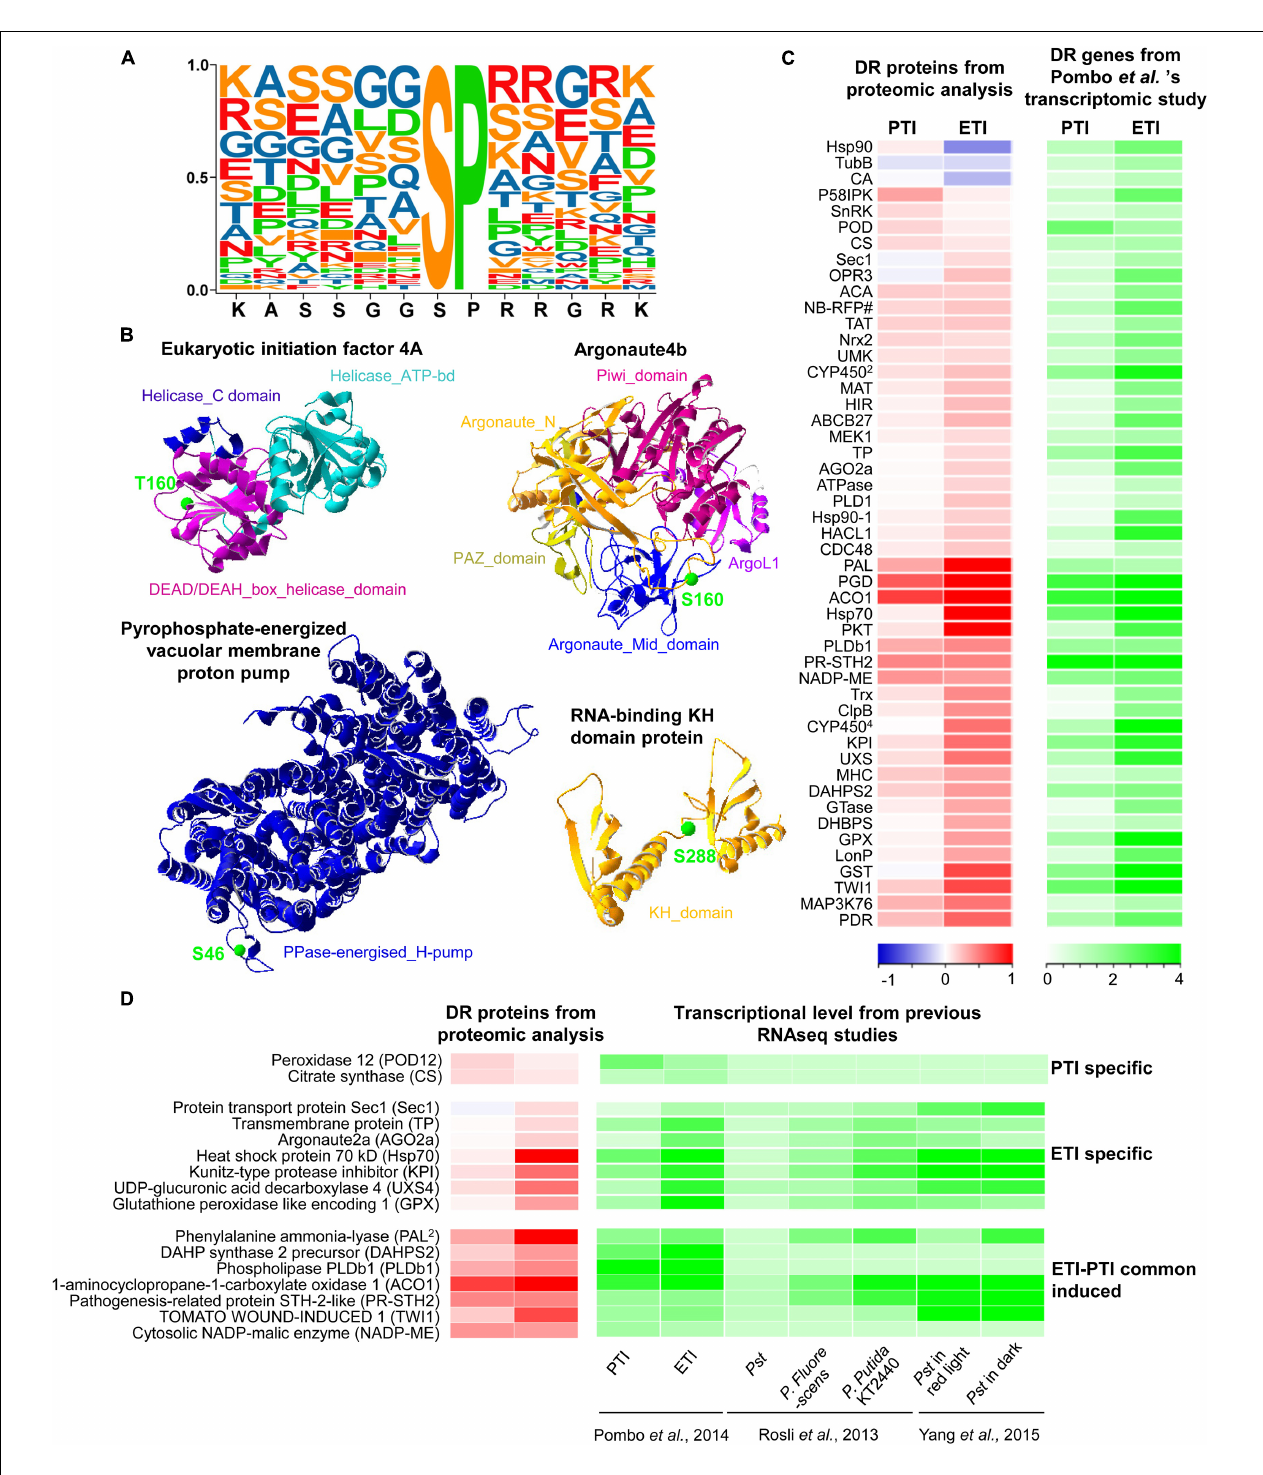
FIGURE 4 | Extracted motifs and predicted 3D structures of DR phosphoproteins, as well as integrative analysis of proteome and transcriptome. (A) A motif extracted from 41 DR phosphosites. (B) 3D structures of four DR phosphoproteins. More detailed information can be found in Supplementary Table 8 . (C) Heatmap of DR proteins with relative changes at the protein level and transcript level from Pombo et al. ’s transcriptomic study. The two columns represent different treatments of PTI and ETI. The rows represent individual proteins. The detailed information is listed in Supplementary Table 9 . The increased or decreased proteins are indicated in red or blue, respectively, and the increased gene transcripts are shown in green. The log 2 ratios of fold-change levels of proteins or transcripts are indicated at the bottom. (D) Heatmap of DR proteins with conserved changes at the protein level and transcript level from multiple RNA-seq studies. The increased or decreased proteins are indicated in red or blue, respectively, and the increased gene transcripts are shown in green.